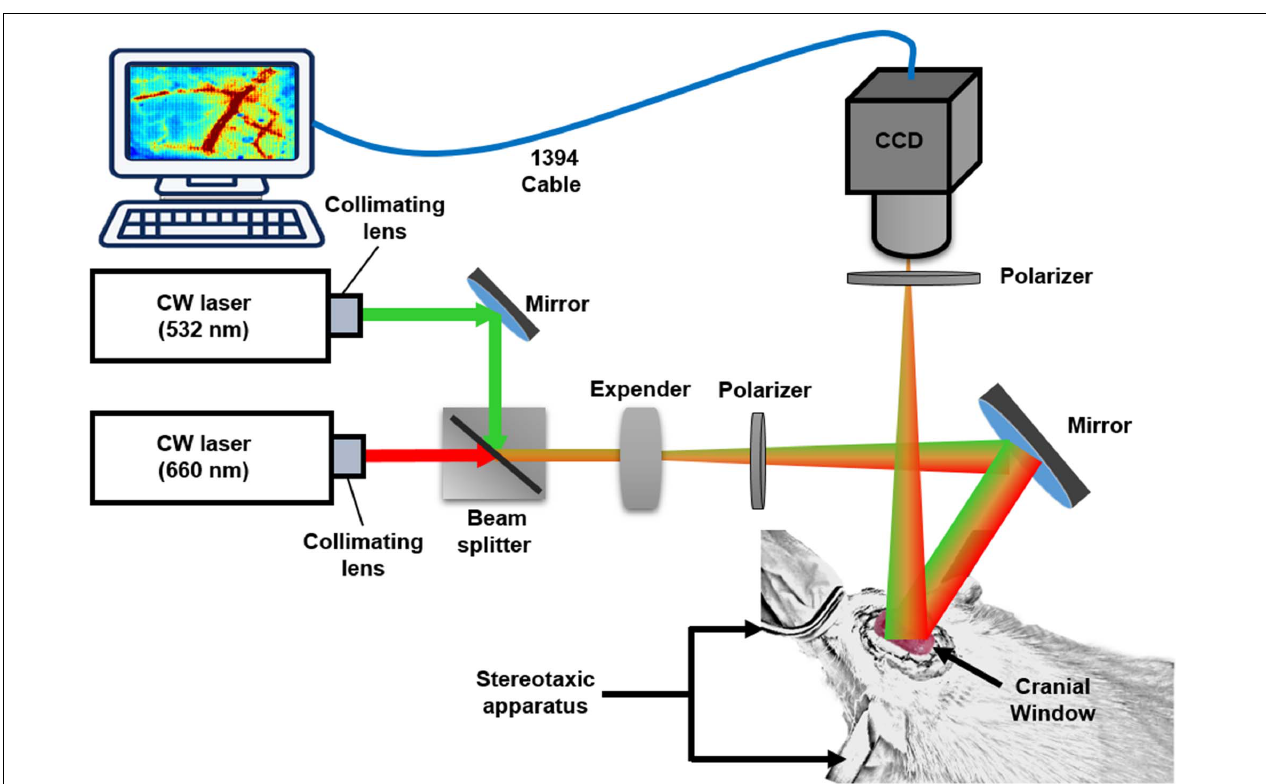
FIGURE 1 | System setup. Multimodal optical imaging system consisting of two CW lasers (532 and 660 nm), a setup of lenses and the CCD camera. The CW 660-nm laser beam was reflected off moving red blood cells (RBCs) and produced speckle for LSCI analysis. The CW 532-nm laser beam was used to measure the absorbance difference by RBCs in vessels and surrounding tissues for OISI calculation. The optical setup was used to couple and expand the two laser beams and illuminate the rat cortex. Two polarizers were used to eliminate the noise reflected from the surface of the cortex. The CCD camera was positioned over the exposed area at an appropriate focal length, and the images were saved and transported to a personal computer via an IEEE 1394 interface for further data analysis. The rat was fixed in a custom-made stereotaxic frame with ear bars, and the surface of the rat brain was imaged through a lab-designed cranial window for LSCI and OISI